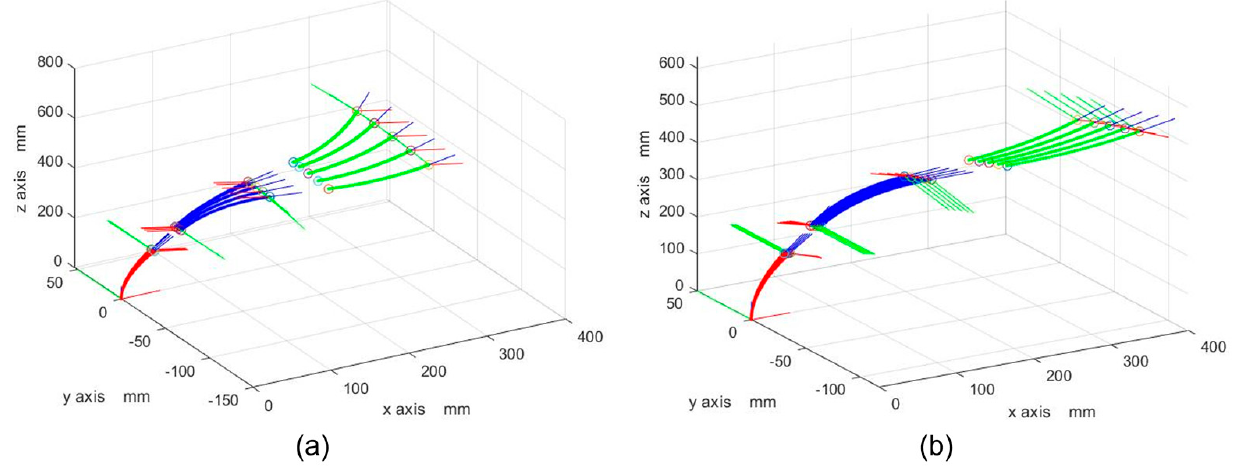
Figure 14. Velocity kinematic simulation of the flexible manipulator: ( a ) change in the end velocity [ 0 20 0 0 0 0 ] ( b ) change in the end velocity [ 20 0 0 0 0 0 ] .